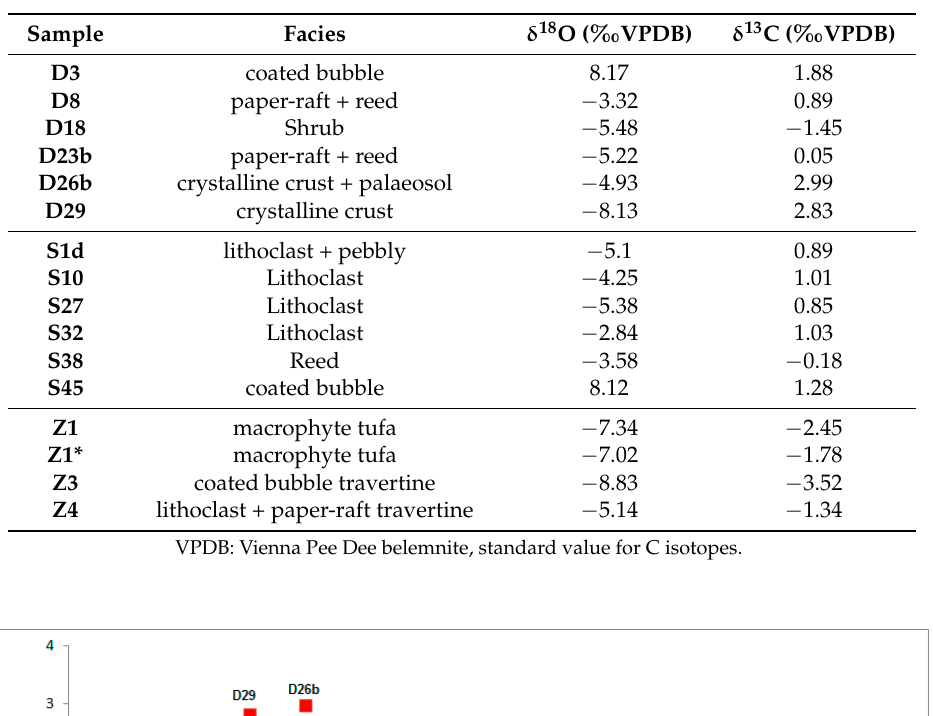
Table 4. Values of δ 18 O and δ 13 C in the studied samples.